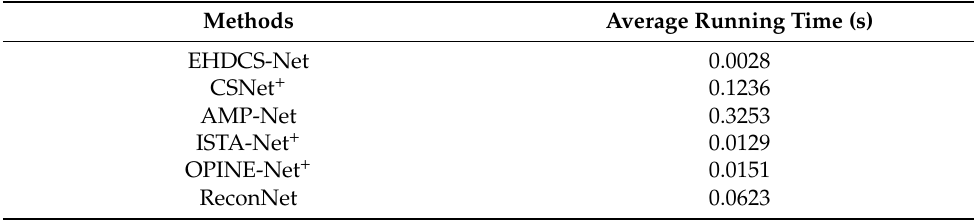
Table 2. Average running time (in seconds) of various deep learning-based image CS methods for reconstructing a large-scene construction site monitoring image (1920 × 1080) in the case of CS ratio =